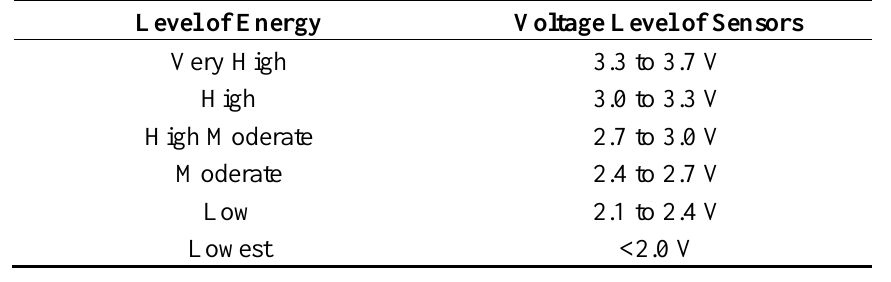
Table 1. Showing distribution of energy level of sensor node.